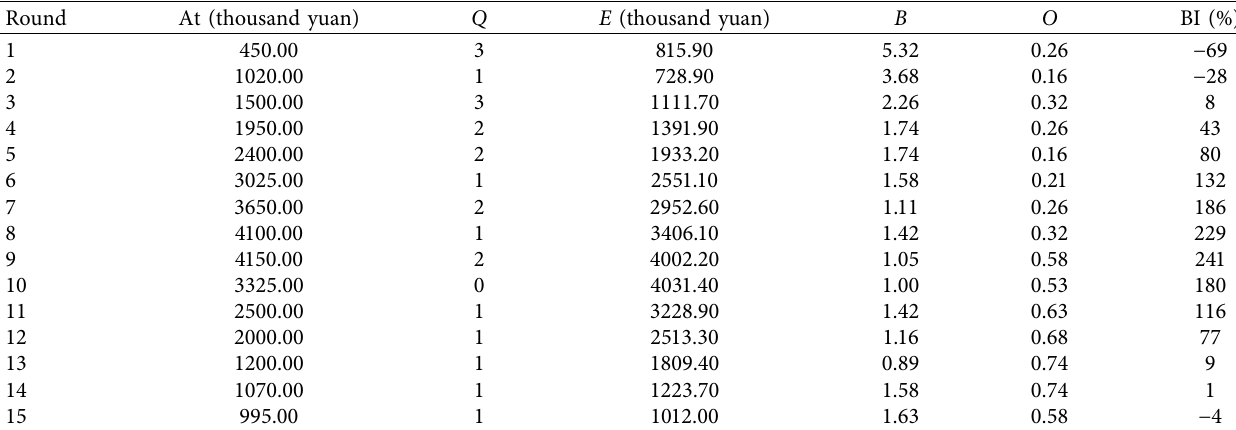
Table 8: Statistical indicators of high lending rate group.